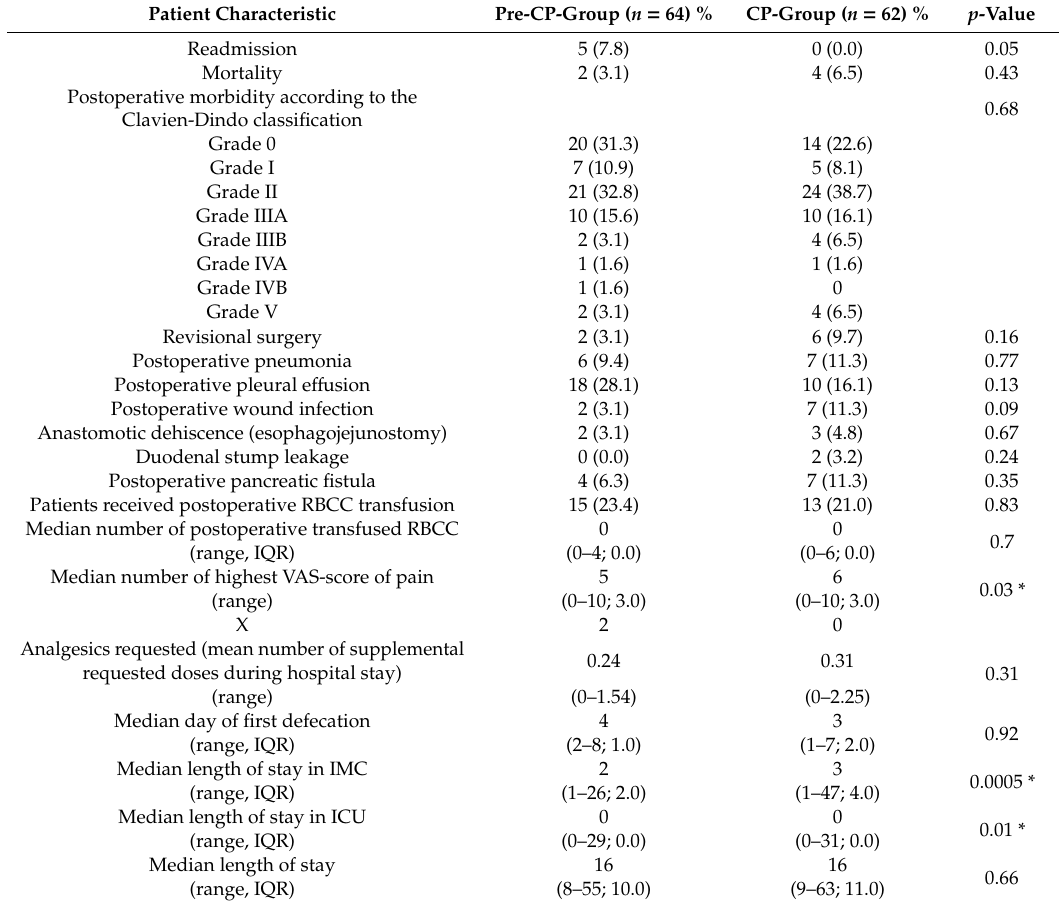
Table 3. Parameters of outcome